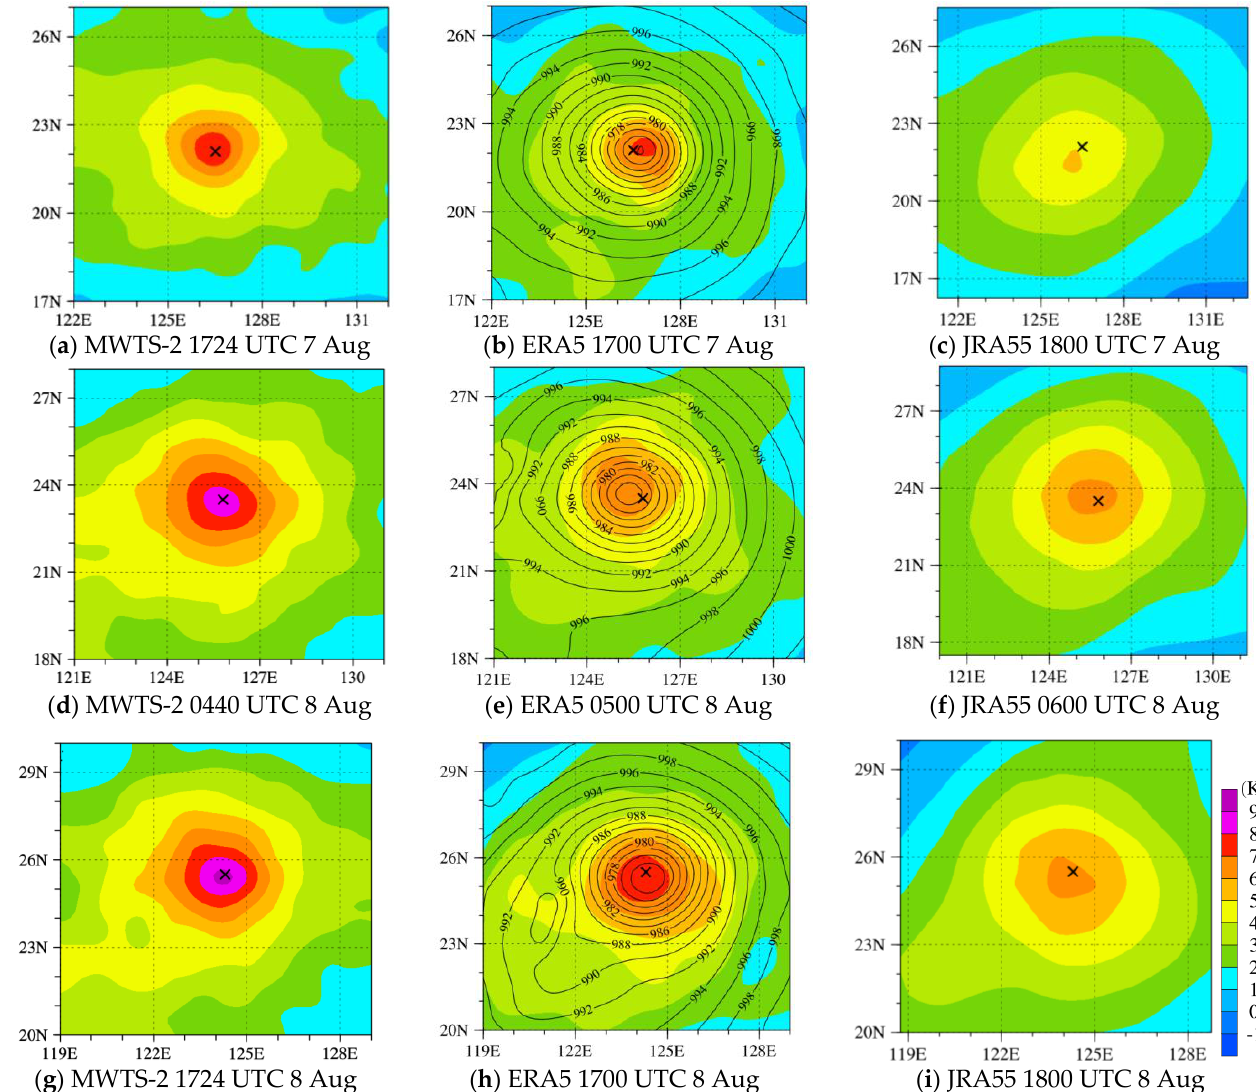
Figure 9. ( a – i ) FY-3D MWTS-2 retrieved (left panels), ERA5 (middle panels), and JRA-55 (right panels) of 250-hPa temperature anomalies for Typhoon Lekima at three selected times during 7–8 August 2019, which are indicated on the top of each figure panel. Also shown in the middle panels are the ERA-5 mean sea level pressure (solid black curve, contour interval: 2 hPa). The black crosses stand for the best track centers of typhoon Lekima.